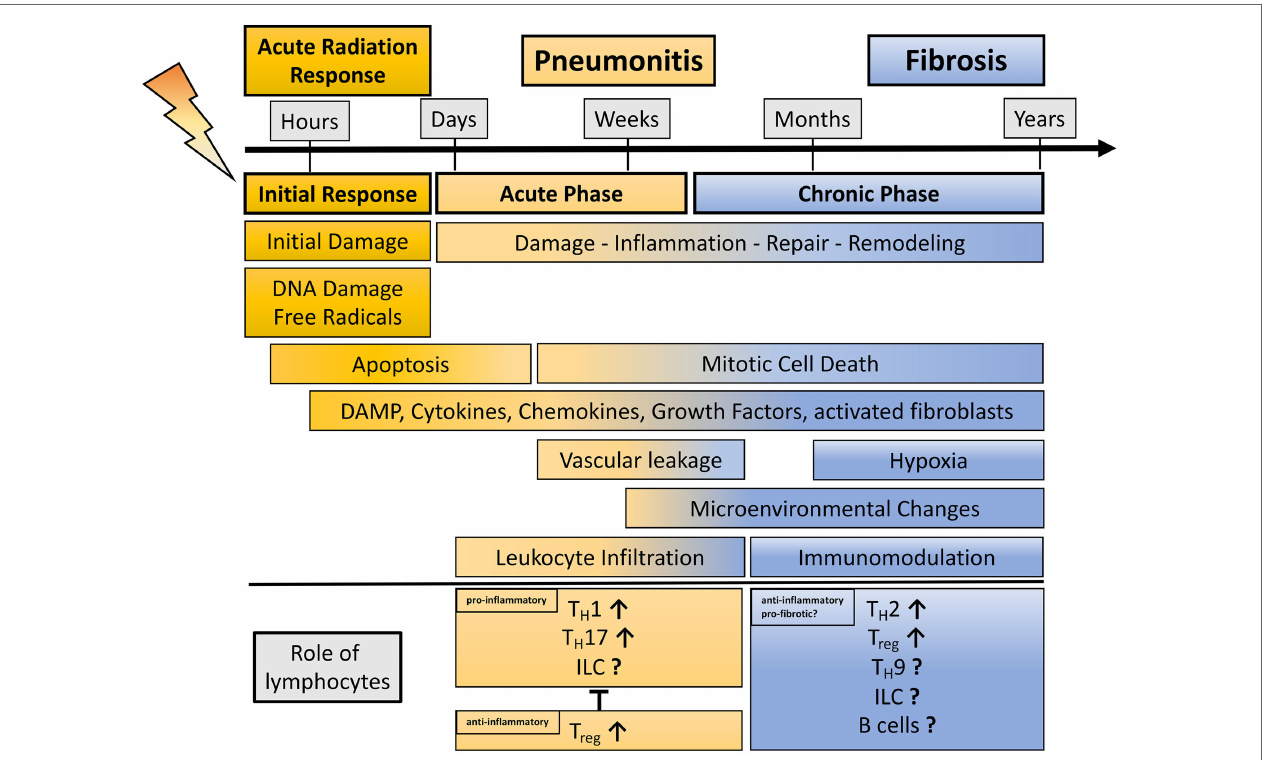
FiGURe 1 | Schematic representation showing the phases of radiation-induced lung injury over time with a view on the dual role of lymphocytes during radiation-induced pneumopathy . Damage to the lung results in an initial response (acute radiation response) due to DNA damage, ROS induction, and apoptosis. Release of damage-associated molecular patterns (DAMPs) and secretion of cytokines and chemokines activate the immune system. This phase passes over into an acute inflammatory phase (pneumonitis) that is characterized by an enhanced pro-inflammatory response and vascular leakage. In this phase, diverse lymphocyte subpopulations like T H 1, T H 17, and potentially innate lymphoid cells (ILC) can contribute to inflammation, whereas it is believed that the lymphocyte subpopulations T reg are needed to control harmful, excessive pro-inflammatory responses. Resolution of inflammation and repair induction is paralleled by late mitotic cell death subsequent, hypoxia, release of DAMP, cytokines, and growth factors. These alterations in the lung micromilieu are described for the chronic phase of radiation-induced pneumopathy. These environmental changes can contribute to immunomodulation; here, it is believed that lymphocytes (T H 2, T H 9, T reg , and potentially ILC) show an anti-inflammatory or even pro-fibrotic phenotype, thereby having the potential to further alter the environment in the lung toward the induction of disease-promoting myofibroblasts and fibrosis